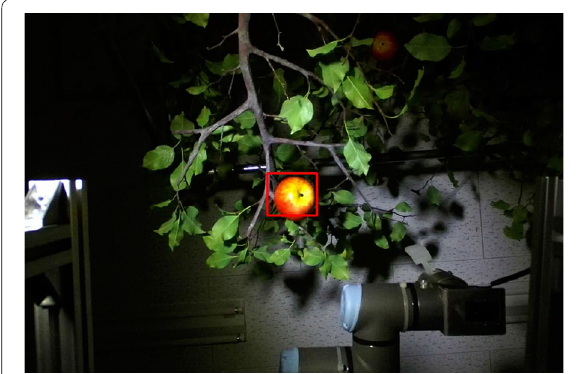
Fig. 12 Detection of two-dimensional position